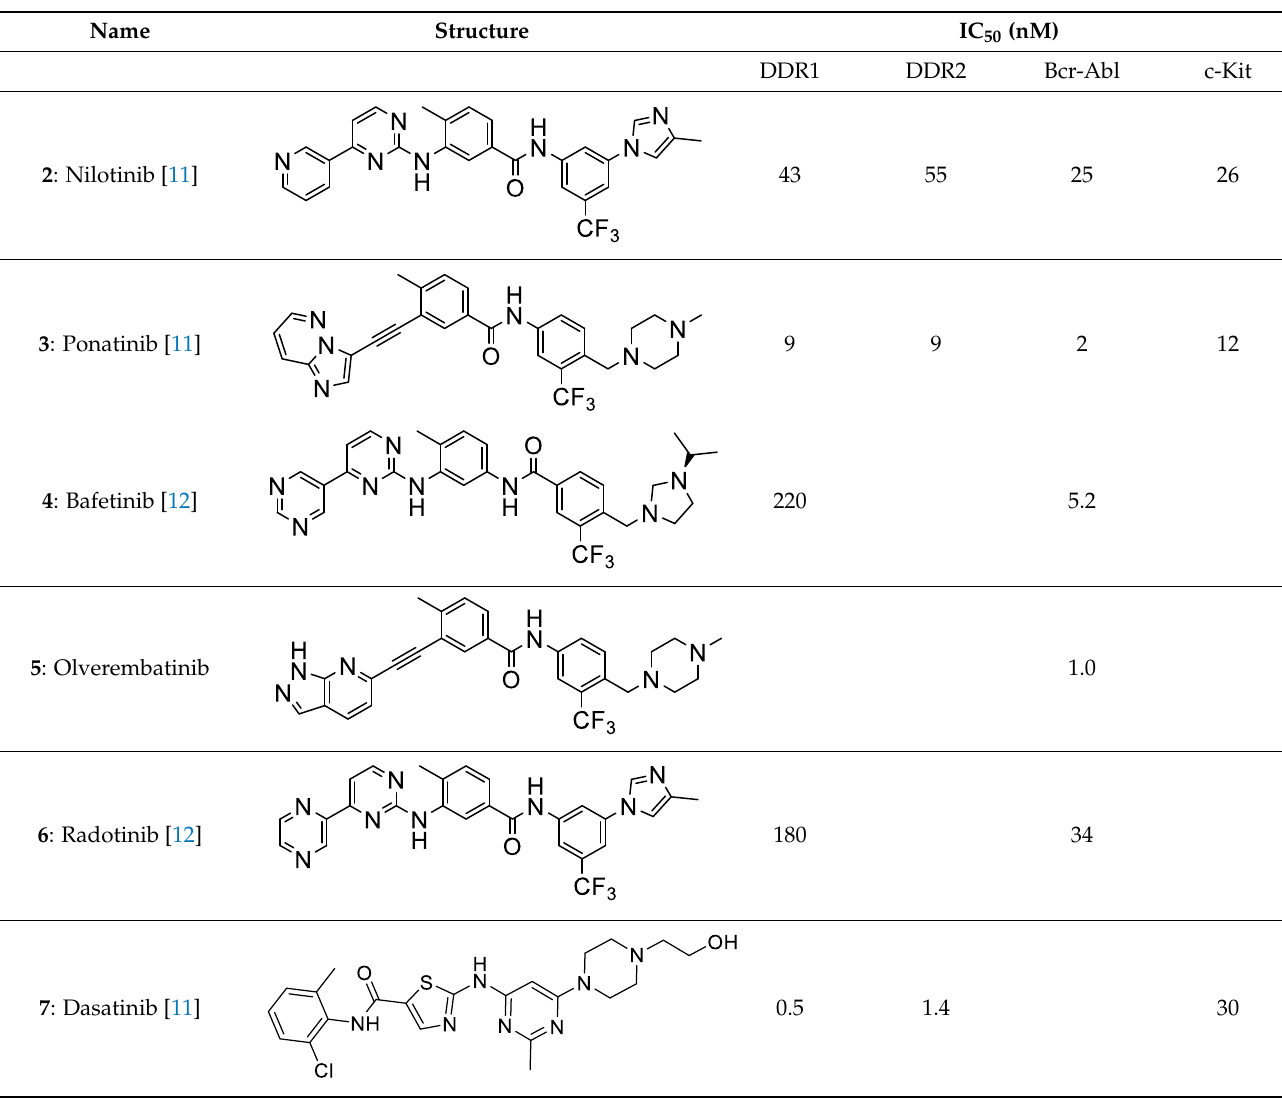
Table 1. DDR inhibition profiles of some approved DDR-binding drugs.